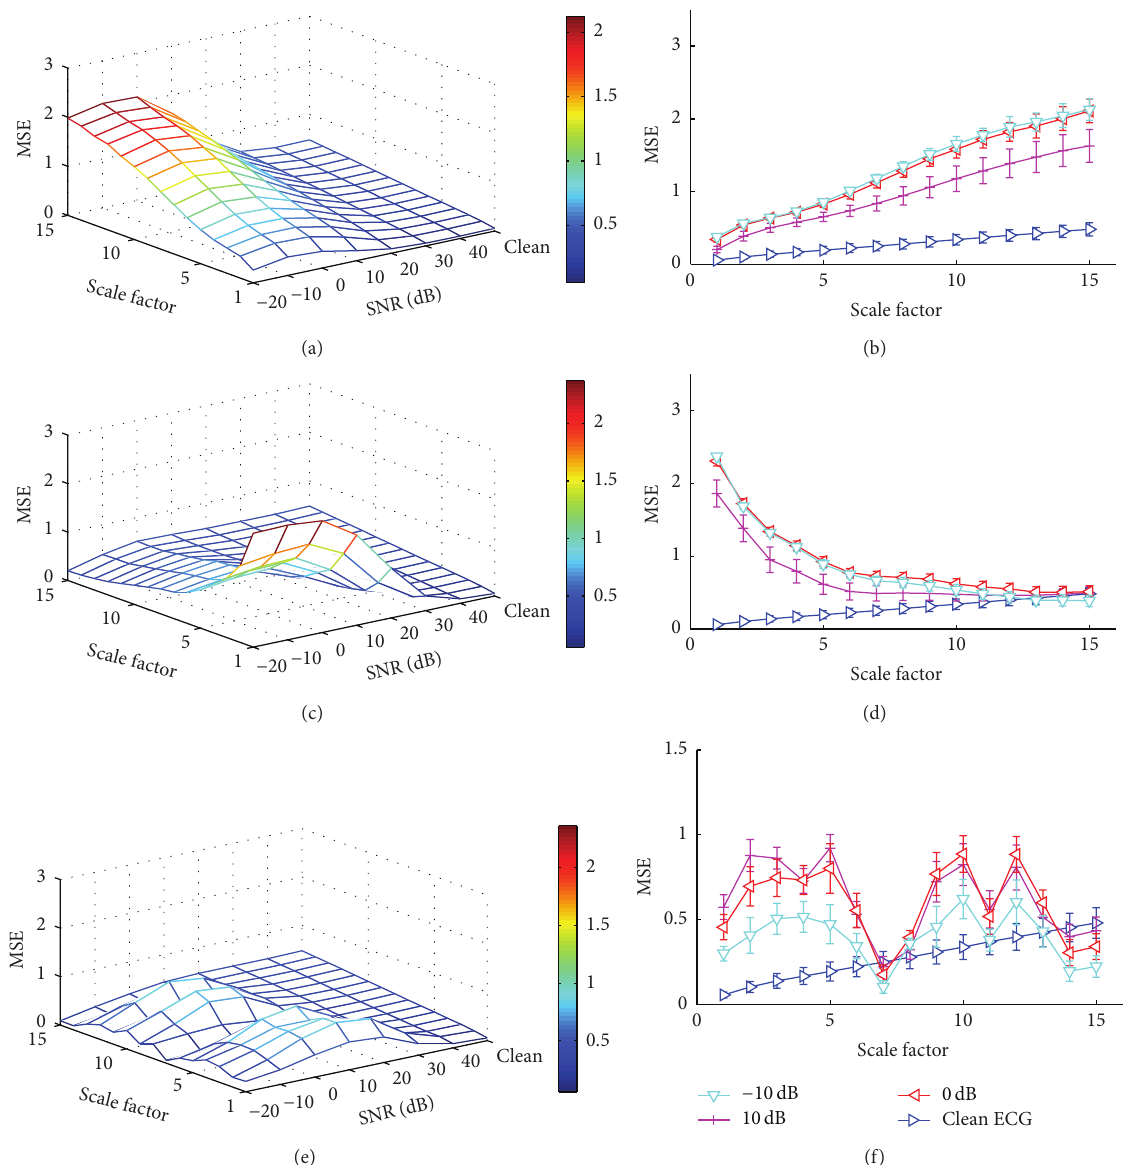
Figure 5: The results of SNR effect on the MSE for the artificial signals. (a) The 3D view of the relationship between MSE and SNRs of the clean ECG plus LF noise. (b) Examples of the clean ECG plus LF noise with SNRs of − 10dB, 0 dB, or 10dB, as well as the clean ECG. (c) The 3D view of the relationship between MSE and SNRs of the clean ECG plus HF. (d) Examples of the clean ECG plus HF with SNRs of − 10dB, 0 dB, or 10dB, as well as the clean ECG. (e) The 3D view of the relationship between MSE and SNRs of the clean plus PL. (f) Examples of the clean plus PL noise with SNR of − 10dB, 0 dB, or 10dB, as well as the clean